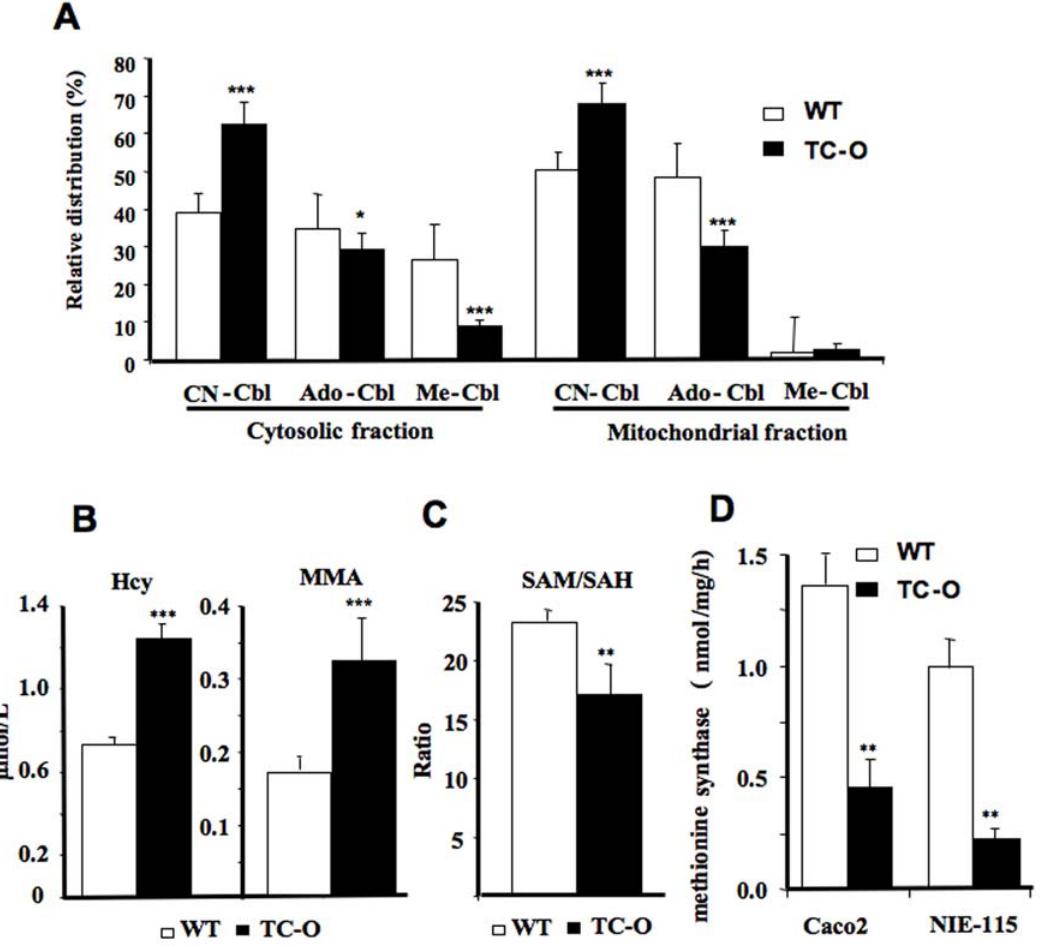
Figure 6. (A) Intracellular conversion of exogenous [ 57 Co]-labeled B12 (cyano-cobalamin, CN-Cbl) into methyl-cobalamin (Me-Cbl) and ado-cobalamin (Ado-Cbl) in the cytosolic and mitochondria enriched fractions. (B) Homocysteine (Hcy) and methylmalonic acid (MMA) concentrations. (C) S-adenosylmethionine/S-Adenosylhomocysteine ratio (SAM/SAH) in TO and wild type NIE-115 cells. (D ) Activity of methionine synthase in TO transfected and wild type NIE-115 and Caco2 cells in exponential growth. Mean 6 S.D. of sextuplet assays are given. ****: p , 0.0001, **: p , 0.001, *: p , 0.001.